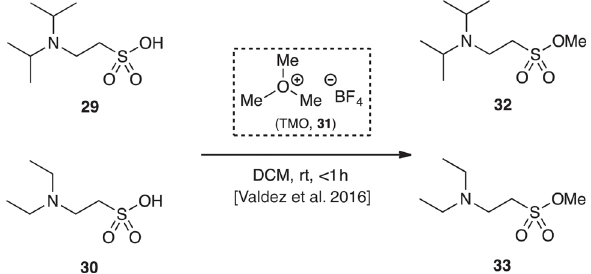
Figure 6: Methylation of N,N -substituted aminoethyl sulfonic acids using TMO . BF to their methyl esters is rapid (<1 h) and at ambient temperature. An important feature of this methodology is the fact that even if the sulfonic acids are not soluble in DCM, they still undergo the